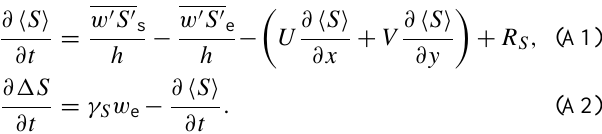
sions and deposition near the surface, advection, entrainment, additional sources and sinks (e.g. due to chemical conversion) and subsidence.